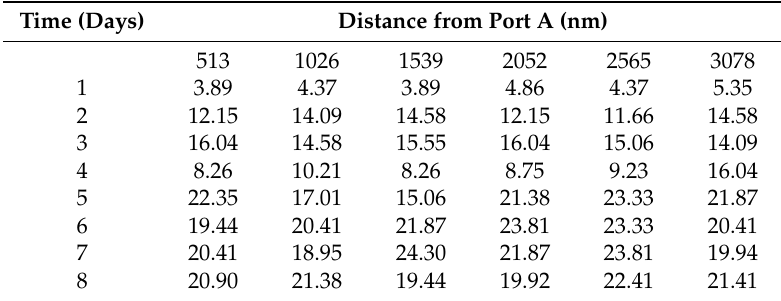
Table A5. Wind speed (in kn) as a function of time and space in Spring. Time (Days)